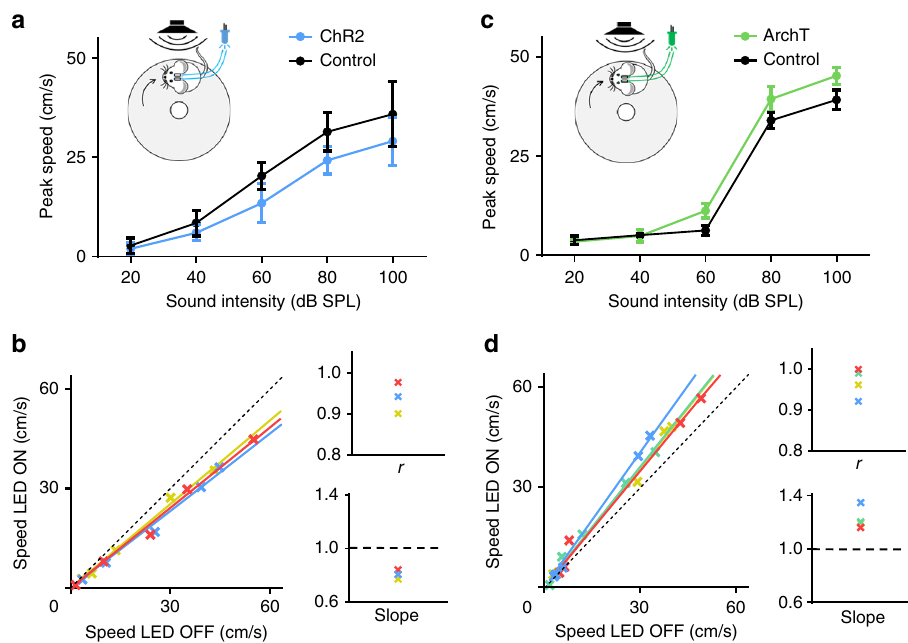
Fig. 3 ZIr activity exerts a gain modulation. a Average peak speeds induced by noise of different intensities without (black) and with (blue) activation of ZIr neurons for an example animal. Inset, illustration of experimental setup. b Left, peak speed in the LED on condition versus that in the LED off condition plotted for three animals. Each color represents one animal. Colored lines represent the corresponding linear regression line. Black dash line is the unity line. Right, correlation coef fi cient calculated for each animal (upper) and the slope for the best- fi t linear regression line (lower). c Average peak speeds induced by noise of different intensities without (black) and with (green) suppression of ZIr neurons for an example animal. d Speed with ZIr suppression versus that without suppression plotted for four